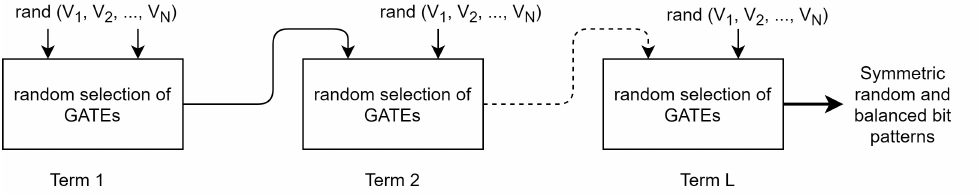
Figure 2. Chaining of